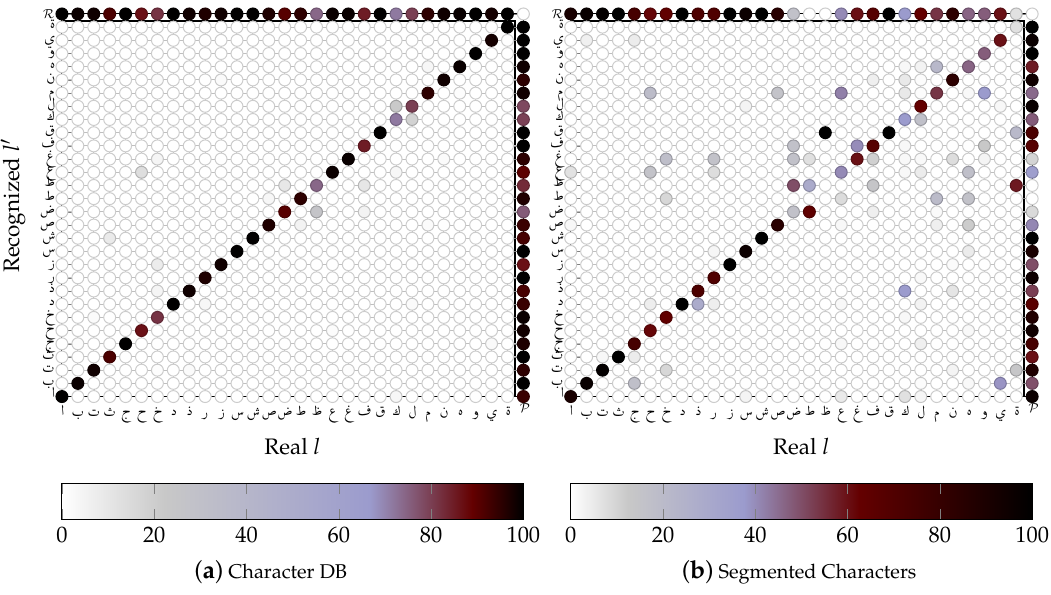
Figure 9. Confusion Matrix of writer independent Support Vector Machines (SVMs). ( a ) SVMs are trained and tested on a character database: average Precision ¯ 94.2116%, average Recall ¯ 94.2063%. P R ( b ) Synthetic words are segmented using GT, than each segmented character is classified using decision = 64.716%, ¯ = trees and SVMs ( ¯ P R